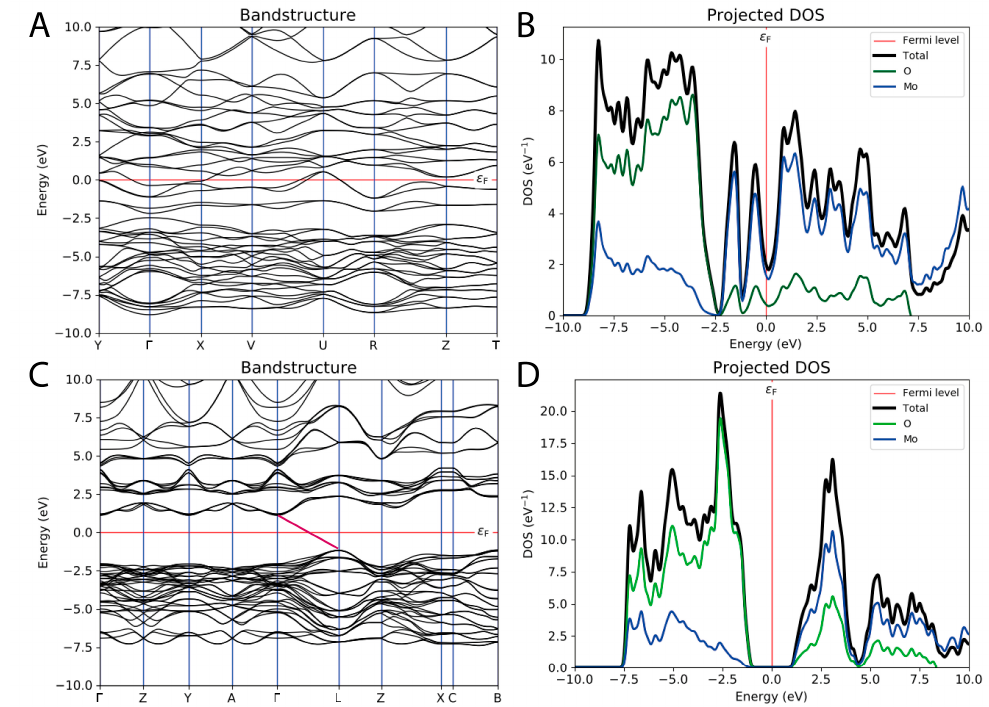
Figure 3. Band structure ( A ) and projected density of electronic states ( B ) of monoclinic MoO 2 . Band structure ( C ) and projected density of electronic states ( D ) of orthorhombic MoO 3 . The Fermi level is depicted as a red line, and the bandgap of MoO 3 is evidenced as a pink line. With the aim of testing the e ff ective reliability of the SCAN functional, the MoO 3 band structure was calculated again using the GGA PBEsol and the hybrid HSE06 functionals (Figure 4). The results were compared with the those obtained with the MGGA approach. The indirect bandgap detected with PBEsol was 2.61 eV, which means that the General- ized Gradient Approximation tended to underestimate the energy gap between valence and conduction bands. Using HSE06, the incorporation of a portion of the exact exchange from Hartree–Fock theory allowed us to obtain an indirect bandgap value of 3.03 eV, which is also in line with other previously conducted studies [38]. In any case, the SCAN functional was found to be the most accurate for the prediction of electrical properties of Mo–O-based systems, and for this reason, all the next calculations reported were per- formed using this MGGA approach. Figure 4. Band structure of MoO 3 calculated with PBEsol and HSE06 functionals. The HOMO–LUMO visualization of both MoO x materials was also reported to be tt er indicate the metallic and dielectric behaviors of MoO 2 and MoO 3 , respectively. Starting